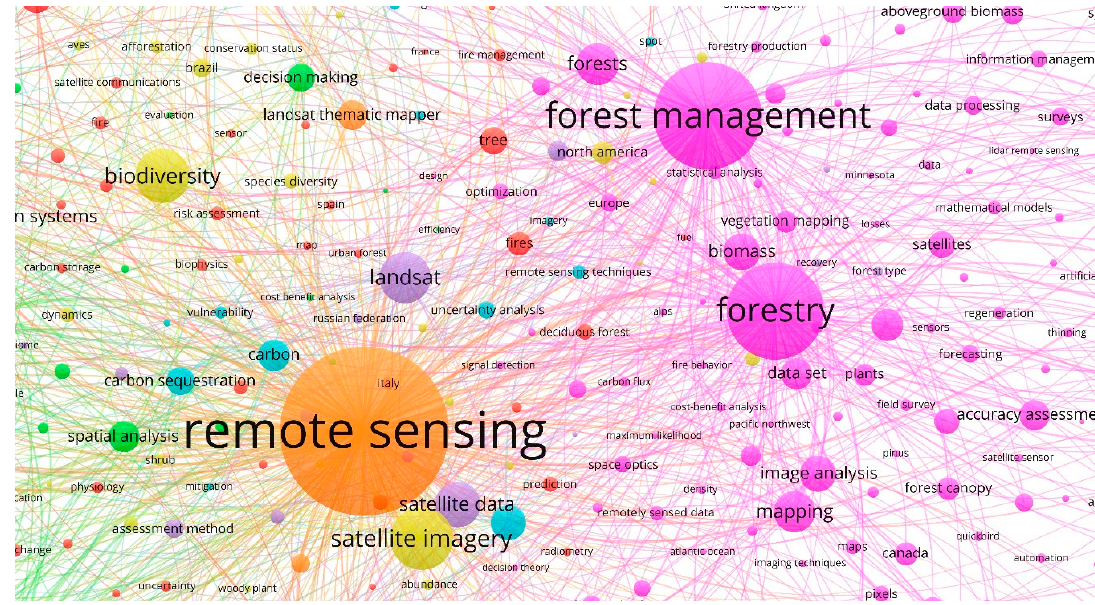
Figure 6. Links of “Forest Management” keyword (1976–2019).